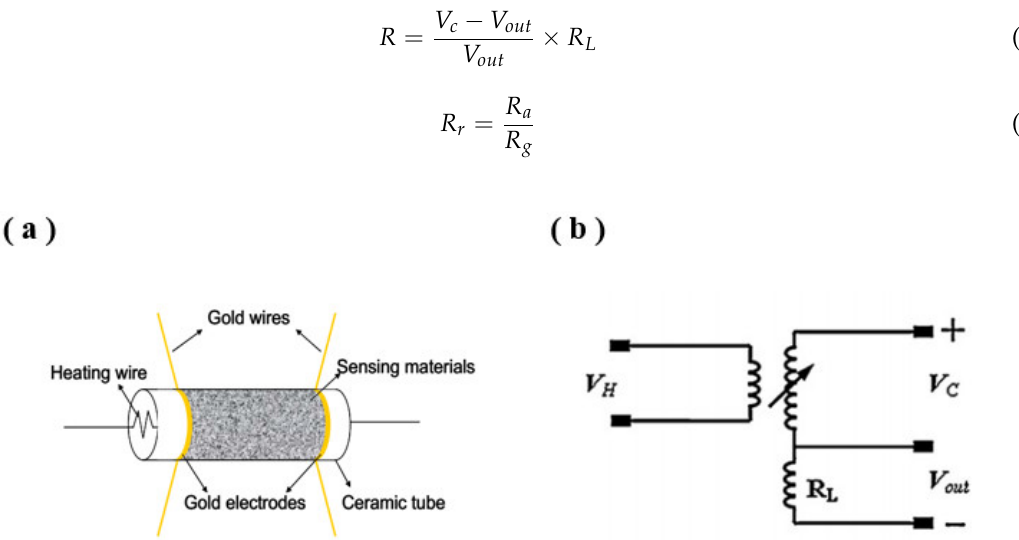
Figure 1. ( a ) The structural sketch of the WO 3 · 0.33H 2 O-based gas sensor and ( b ) the measuring electric circuit of the sensor.